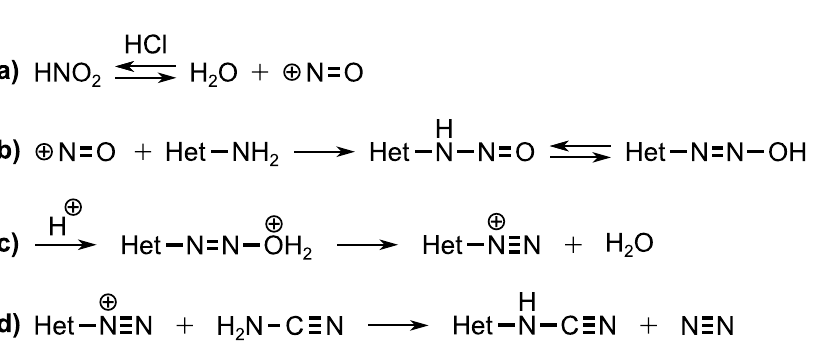
Figure 3. The formation of major adducts identified from N-heterocycles (labeled Het) incubated with Miller- Urey spark discharge mixtures. Major reactions were identified by grouping adducts based on chain length, terminal functional group, and whether the chain was saturated (see Supplementary Table S6 for details). This grouping revealed that the majority contained alkyl and acrylic side chains 1–3 carbons in length with terminal aldehyde or CN/CONH 2 /COOH groups. Of these groups, only the individual adducts that that were formed by at least 10 N-heterocycles were deemed major and included in this figure. Blue, red, and purple arrows indicate the reaction was robust when N-heterocycles were incubated with mixtures formed under a reducing atmosphere, neutral atmosphere, and both atmospheres, respectively. For clarity, reactants are shown as their nitrile precursors and adducts as their final hydrolysis product (carboxylic acids and aldehydes). * Indicates that it is equally plausible that a structural isomer of the reactant (methacrylonitrile and 3-butyn-2-one for crotonitrile and methylpropiolaldehyde, respectively) attacked the N-heterocycle, forming a structural isomer of the structure shown (see Supplementary Table S2 for the possible structures).